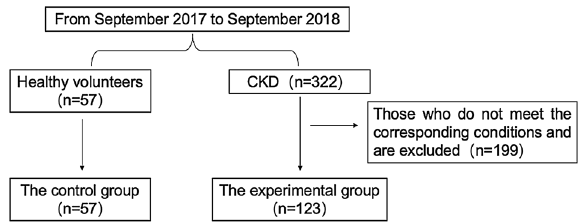
Figure 1. Flow diagram of selection between experimental group and control